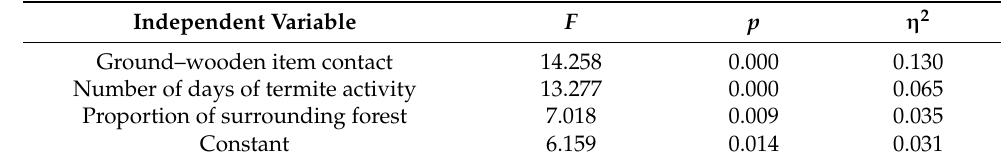
Table 1. Results of the general linear model for ground–wooden item contact, number of days of termite activity, and proportion of surrounding forests as independent variables, and the degree of termite damage as the dependent variable ( R 2 = 0.245, revised R 2 = 0.229). Independent Variable